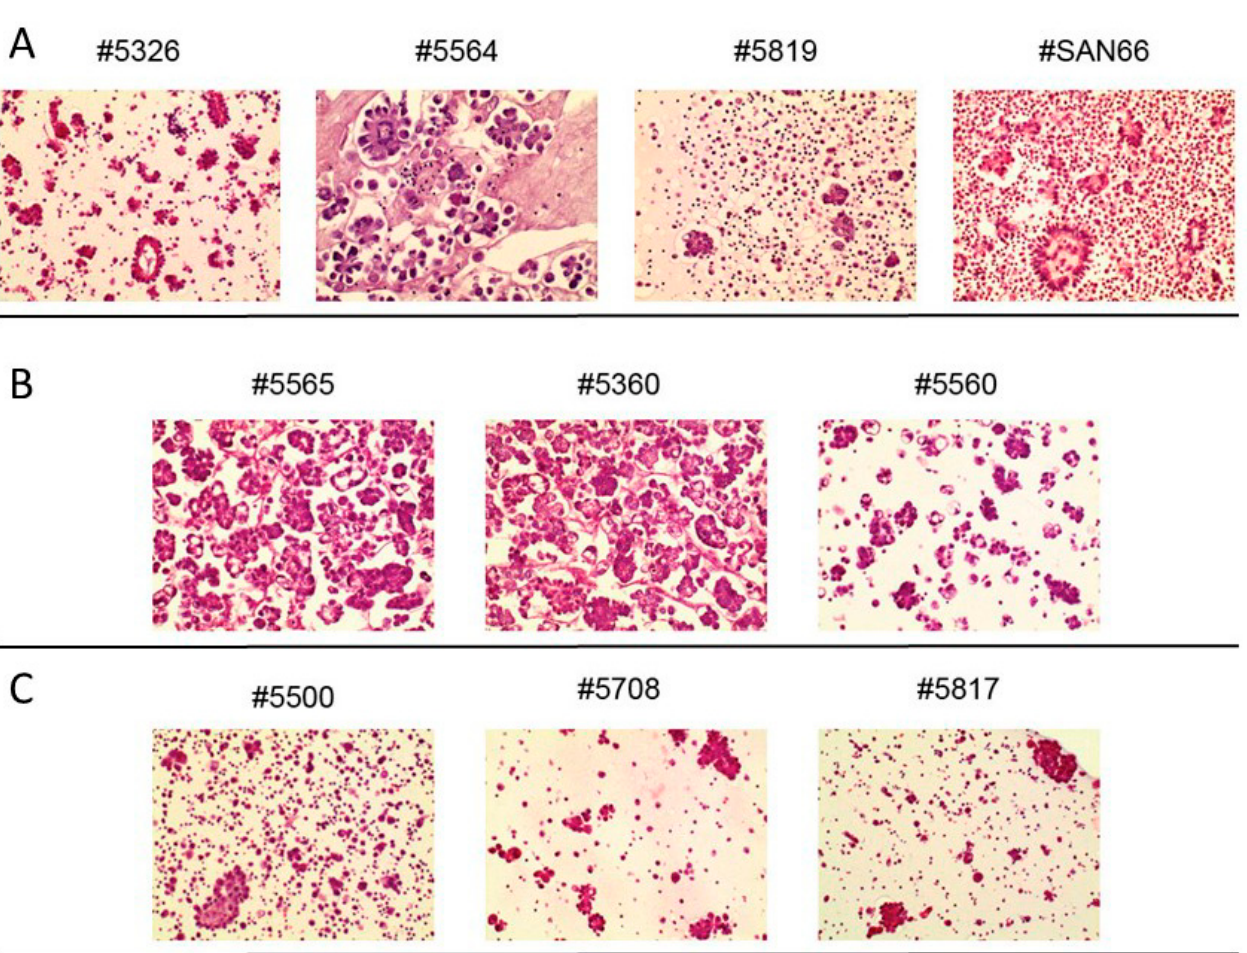
Figure 1. H&E staining of spheroids from different patients’ paracenteses ( A ) and three longitudinal samples of ascites collected from one relapsed patient ( B ) and from another relapsed patient ( C ). Numbers on top of each panel correspond to the Profiling protocol numbers of the collected ascites. Details of each #case are in Supplementary Table S1. 20× magnification.